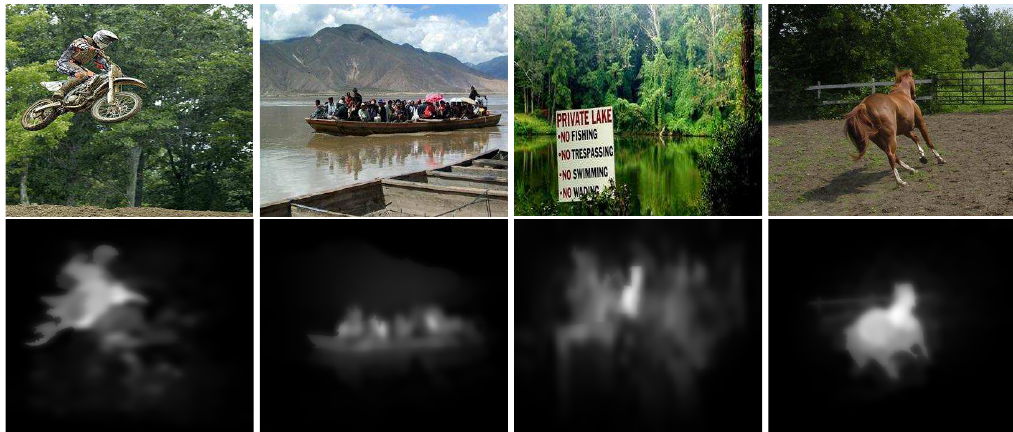
Figure 14. A few cases where our model performance is not very